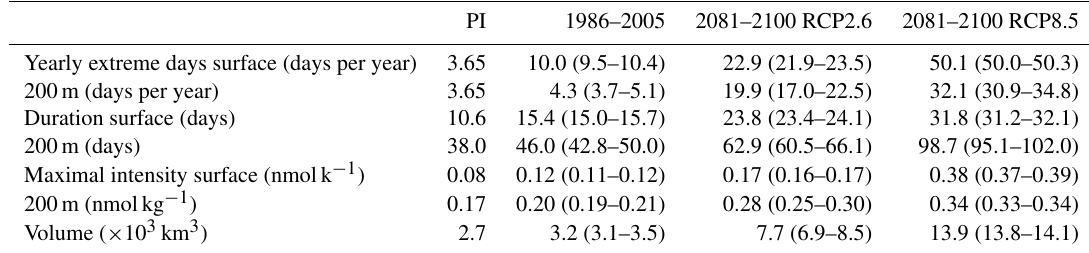
Figure 5. Simulated changes in globally averaged [H + ] extreme-event characteristics over the 1881–2100 period following historical (black lines) and future RCP8.5 (red) and RCP2.6 (blue) scenarios. The extreme events are defined with respect to a shifting baseline. Yearly extreme days, maximal intensity, and duration are shown for the surface (a, c, e) and for 200m (b, d, f) . Volume is shown in (g) . The thick lines display the five-member ensemble means, and the shaded areas represent the maximum and minimum ranges of the individual ensemble members. Table 2. Simulated global ensemble-mean [H + ] extreme-event characteristics, when extremes are defined with respect to a shifting baseline. Values in brackets denote ensemble minima and